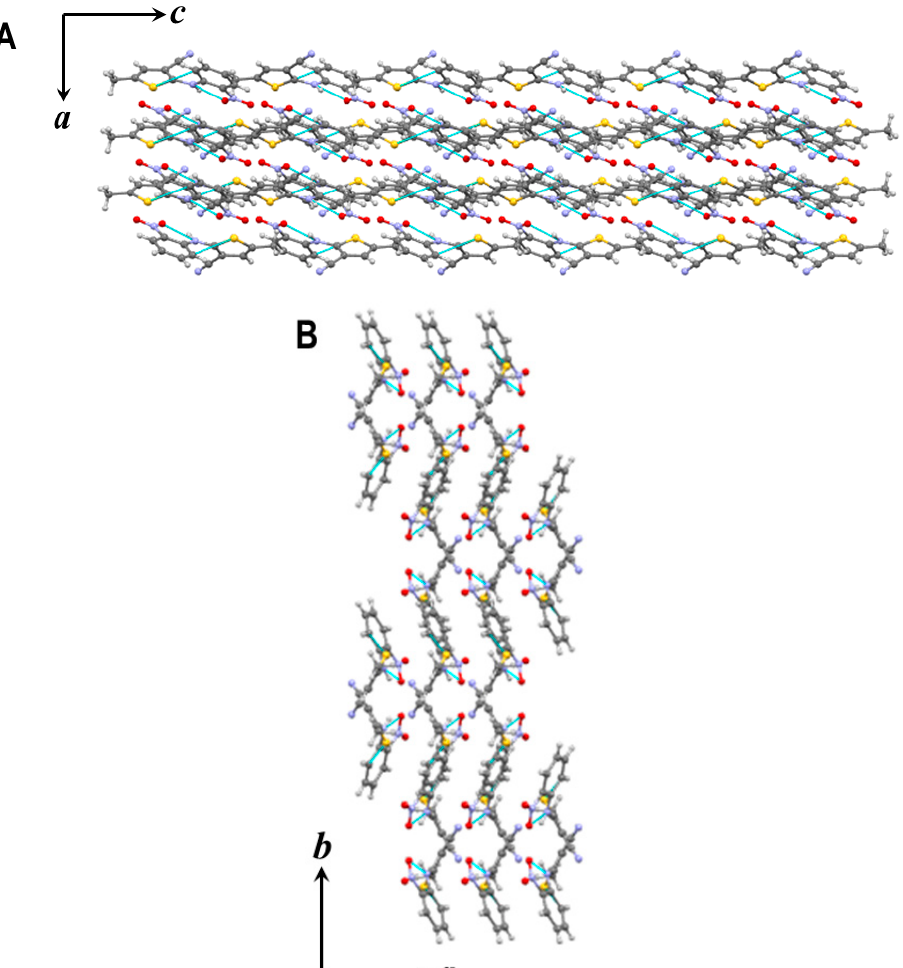
Figure 5. Crystal packing in polymorph OP showing hydrogen-bonded layers. Intermolecular (red lines) and intramolecular hydrogen bonds (teal lines) are shown.